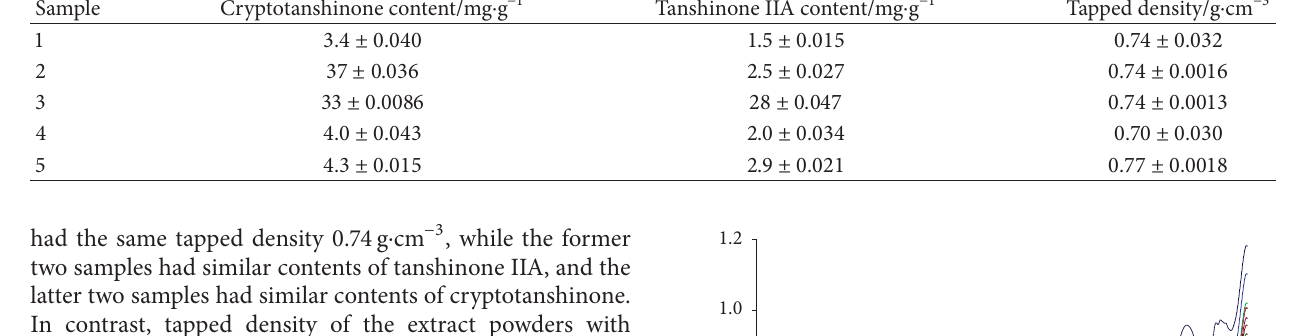
Table 5: The contents of cryptotanshinone and tanshinone IIA, bulk, and tapped density of five samples exemplified. Sample